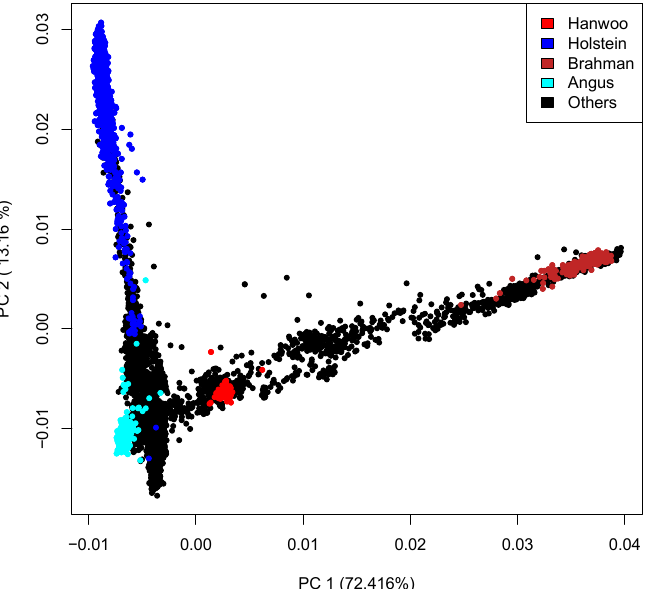
Figure 2. Plot of first two principal components of the large multi-breed reference including Hanwoo animals.